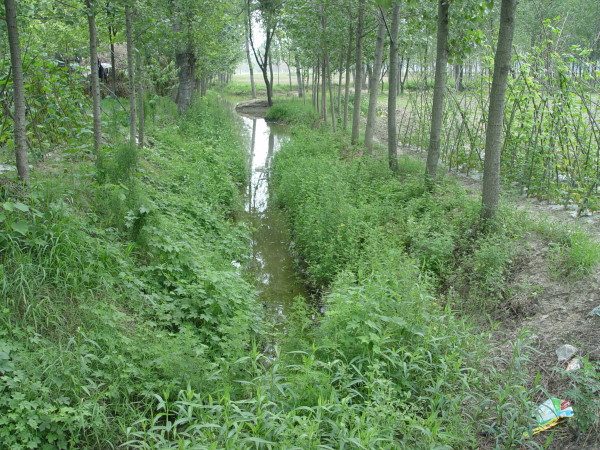
 Water bodies. a. Shows the stream around the villages, which are considered and defined to be one kind of water body. b. Shows another kind of water body: accumulated water on the ground in the villages.